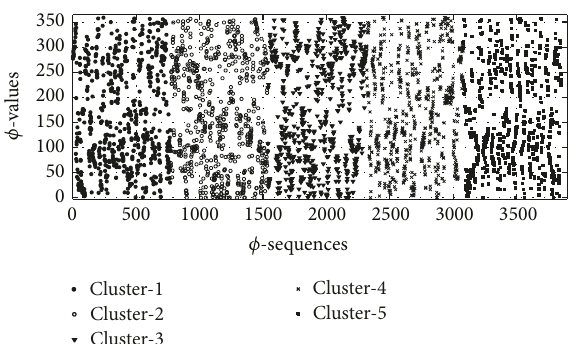
Figure 2: 5 clusters extracted from the azimuthal space correspond- ing to a sample pseudorapidity data set around 𝑐 𝑟 for 32 S-AgBr ( 200 AGeV)